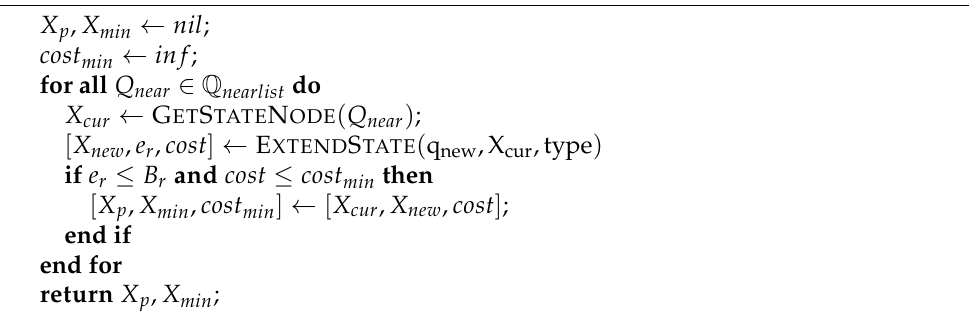
Algorithm 2 F INDING P ARENT S TATE * { Q nearlist , q new , type